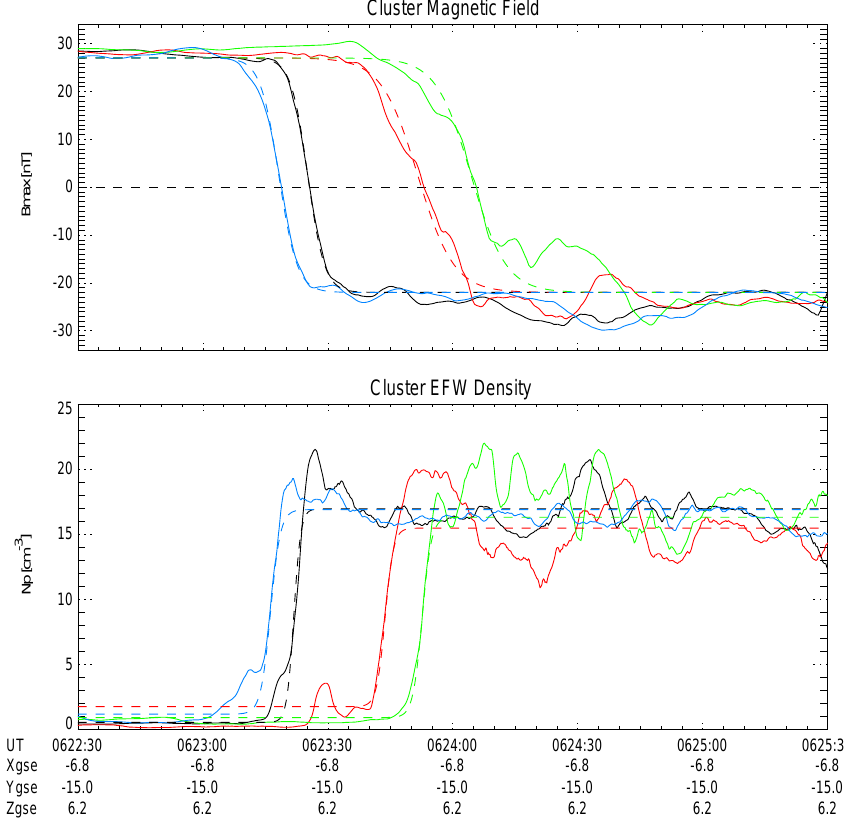
No data Fig. 2. Fitting of hyperbolic tangent curves for magnetopause encounters by Cluster on 5 July 2001, 06:22:30–06:25:30 UT. Top panel: fitting to maximum variance magnetic field component (6-s sliding averages at 0.2-s resolution). Bottom panel: Fitting to plasma density data, derived from EFW instruments (4-s sliding averages at 0.2-s resolution). Color code as in Fig.